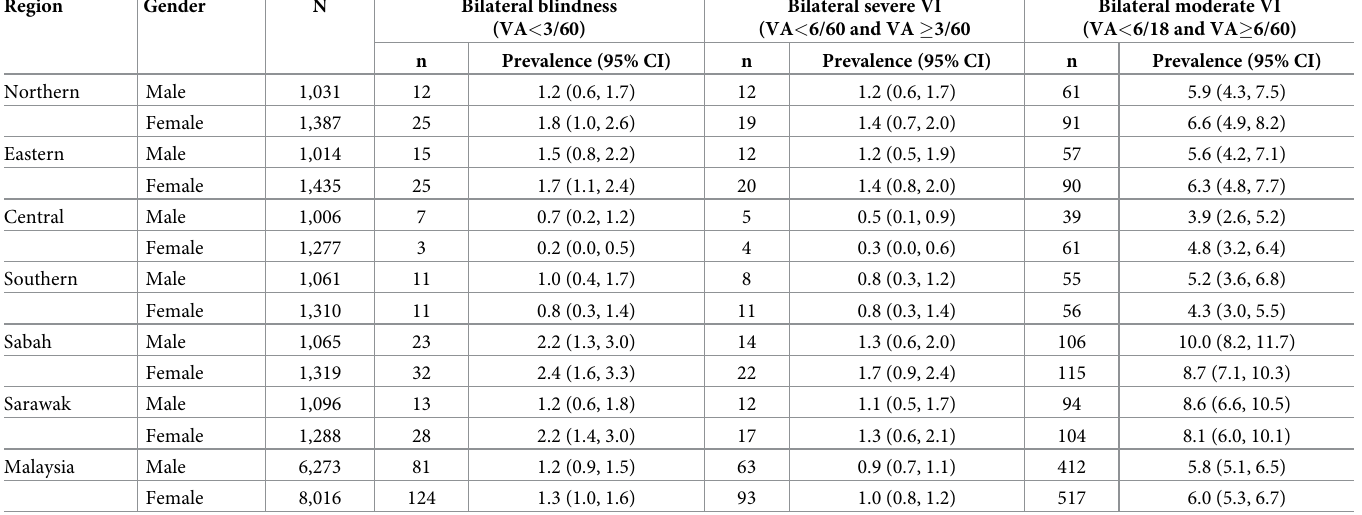
Table 2. Distribution of PVA (presenting visual acuity) in the better eye in the sample population.